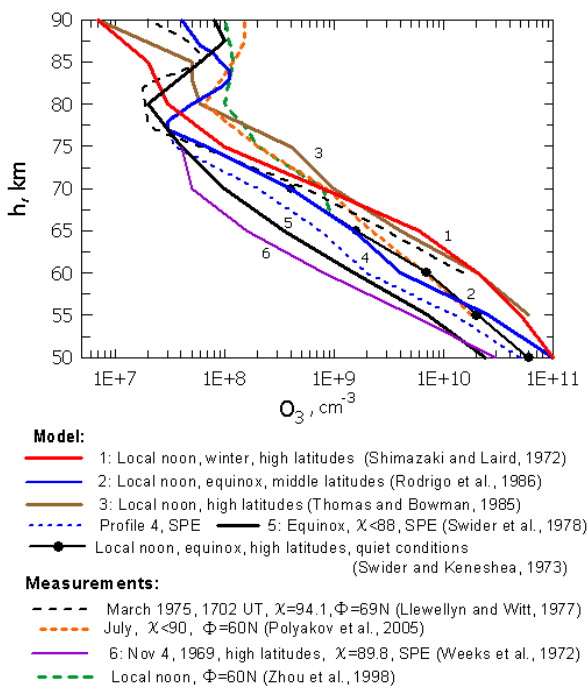
Fig. 1. Examples of the height distribution of the ozone concentra- tion in the D-region obtained from measurements and from theoret- ical